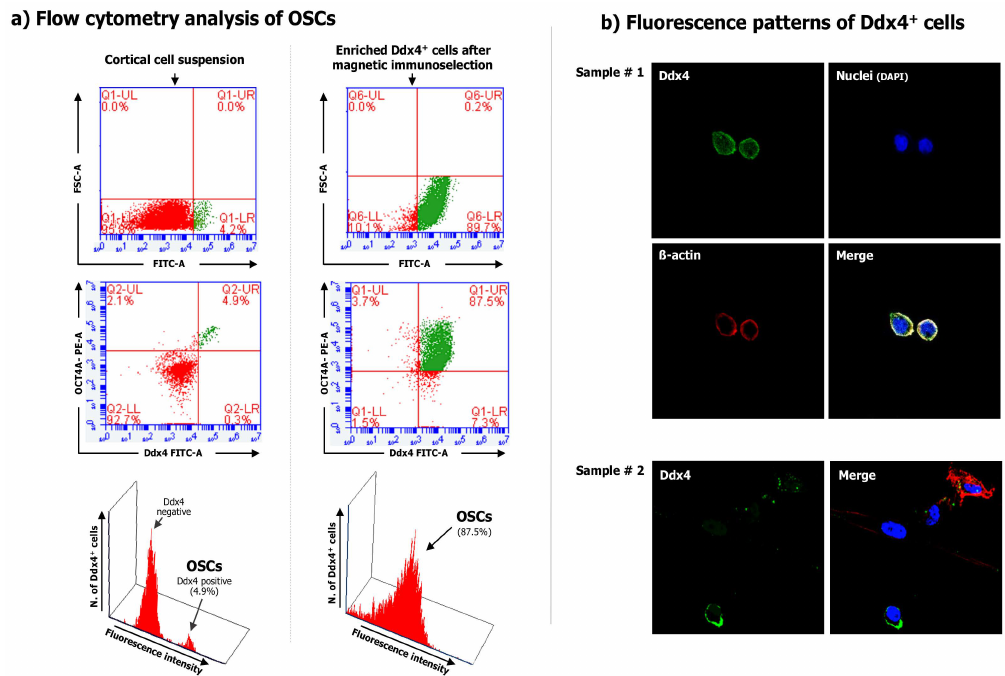
Figure 1. Ddx4 expression on the cell population purified from the ovarian cortex.( a ) Flow cytometry for Ddx4 expression measured in both total cortical cell suspension (left) and after Ddx4 + cell selection emphasized the small population extent in the cortex (4.9%) and its subsequent enrichment (87.5%). ( b ) Immunofluorescence for Ddx4 expression in two samples of purified Ddx4 + cells by confocal microscopy. The fluorescence patterns confirm the membrane localization of Ddx4 (FITC; green), while the cell integrity was assessed by both actin (phalloidin; red), and nuclei (DAPI; blue)